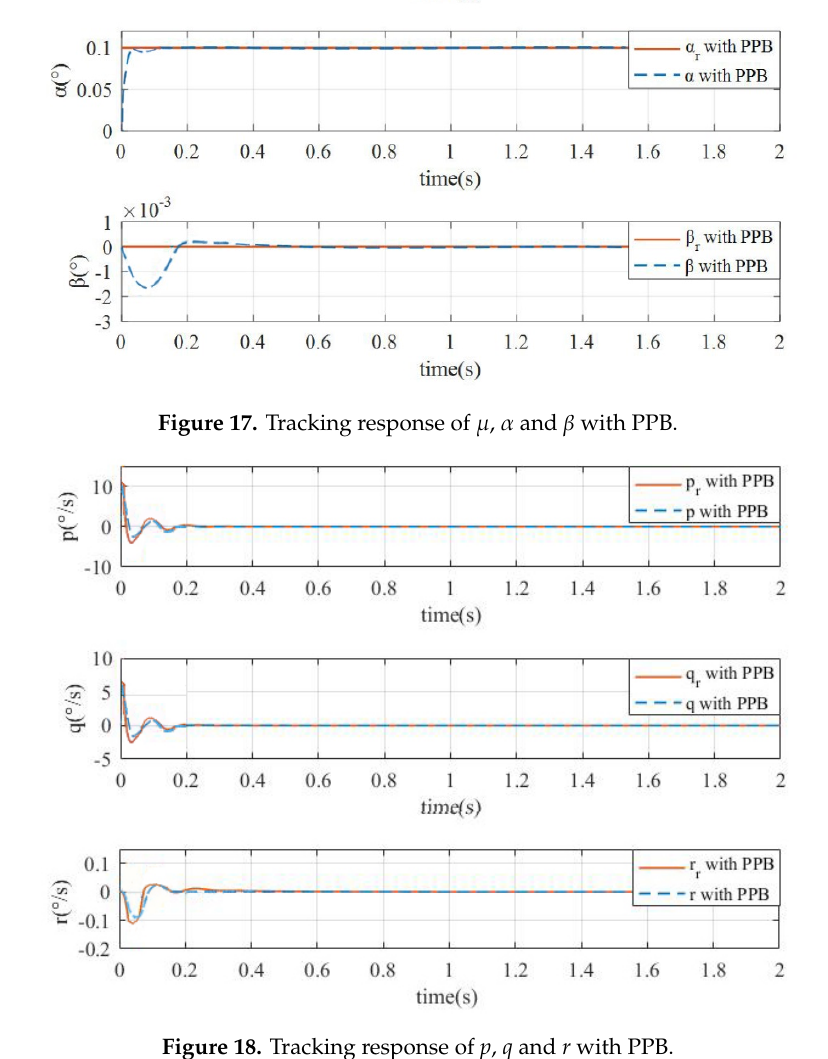
Figure 18. Tracking response of p , q and r with PPB.